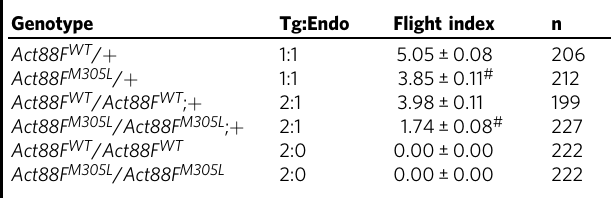
Table 1 Flight indices of Drosophila expressing varying amounts of transgenic versus endogenous Act88F